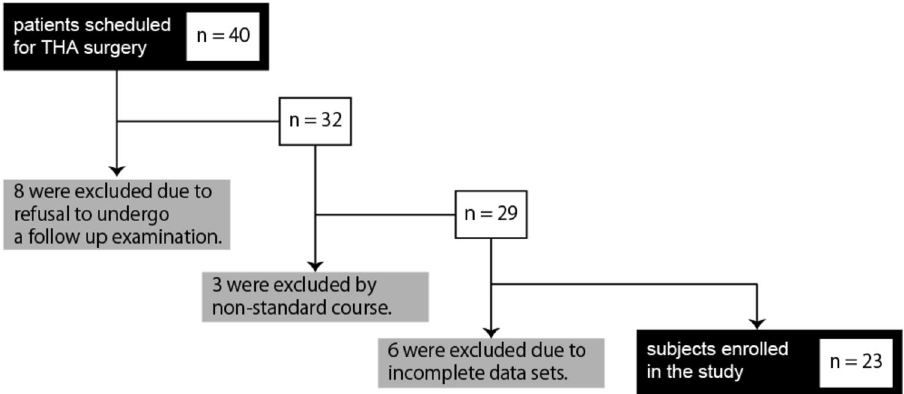
Figure 2. Flow chart of study subjects. Eight patients were excluded due to refusal to undergo follow-up examination, three were excluded by non-standard course such as re-operation, and six were excluded due to incomplete data sets. Most patients who refused undergo an examination were unable to walk continuously for 5 min.